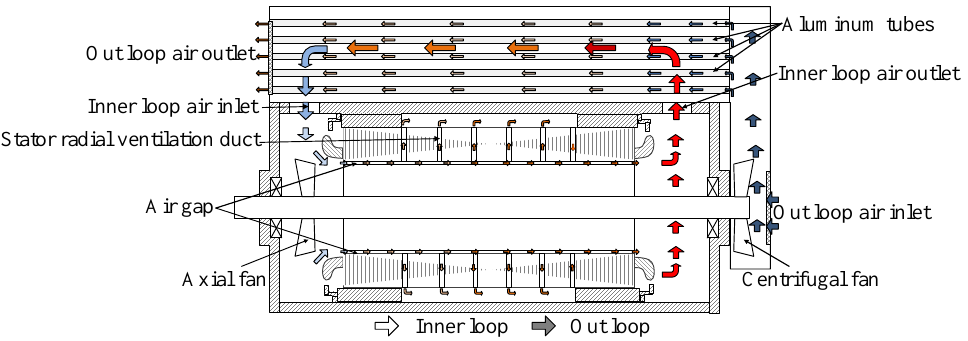
Figure 5. The air-cooled hybrid ventilation systems of HVLSSR-PMSM with single ventilation